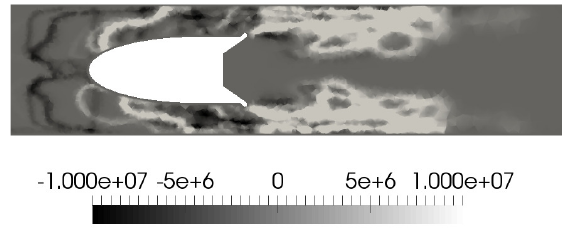
Figure 5. Map of the Rayleigh